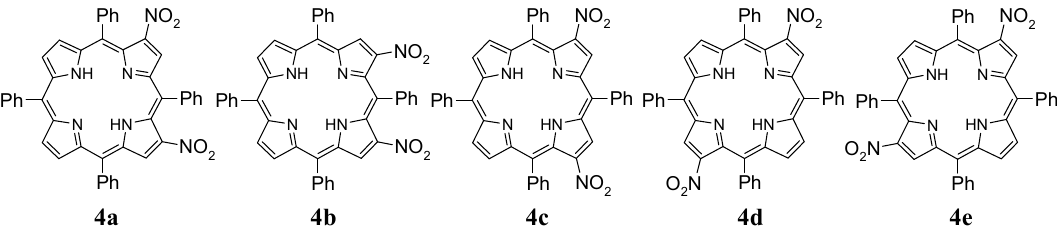
Scheme 1. Preparation of dinitro-isomers and all the possible structures of the products.